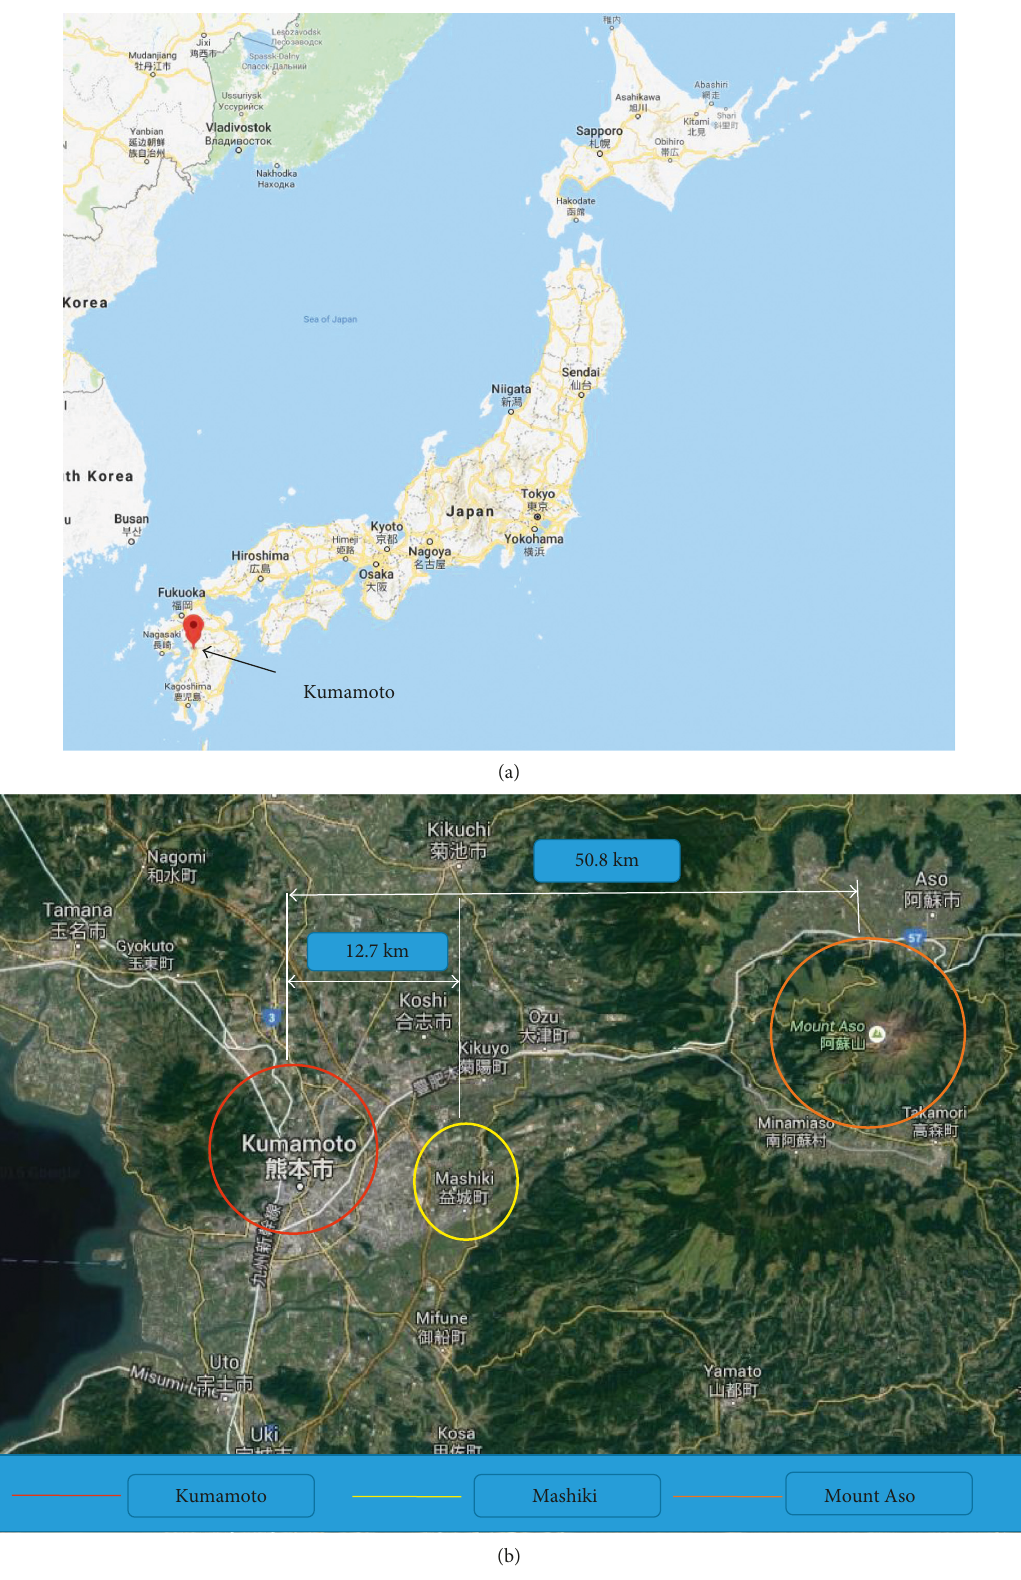
Figure 1: (a) The location of Kumamoto. (b) Distances between Kumamoto and Mashiki and Mount Aso. Source: